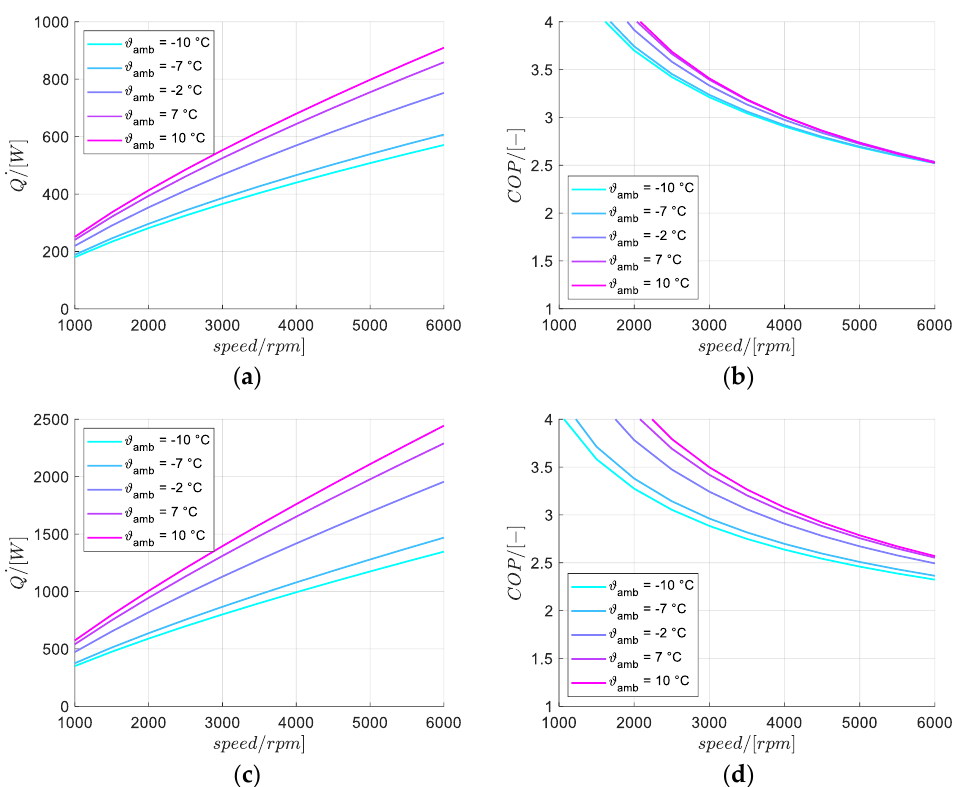
Figure 14. Performance map of the total thermal power of the heat pump and the COP for supply air heat pump system (top, ( a , b )) and supply air heat pump with secondary air recirculation (bottom, ( c , d )) with an additional ambient air of 200 m 3 /h as the source. The total heating power was split between the condenser (50%) for the supply air and the desuperheater (50%) for secondary air. Both HPs are combined with an ERV. The performance maps are reported between 1000 rpm and 6000 rpm and the ambient temperatures between − 10 ◦ C and +10 ◦ C, while the operation of the HP is limited between about 1800 rpm and 6000 rpm and for the supply air heating system to around 1000 W (typically max. 10 W/m 2 ) in order to not exceed